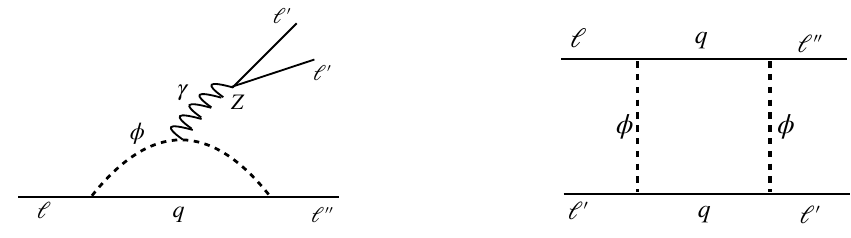
Figure 2 . Penguin and box scalar leptoquark ( (cid:30) ) contributions to the decays ‘ ! ‘ 0 ‘ 0 ‘ 00 . Diagrams with the leptoquark and quark lines interchanged are not